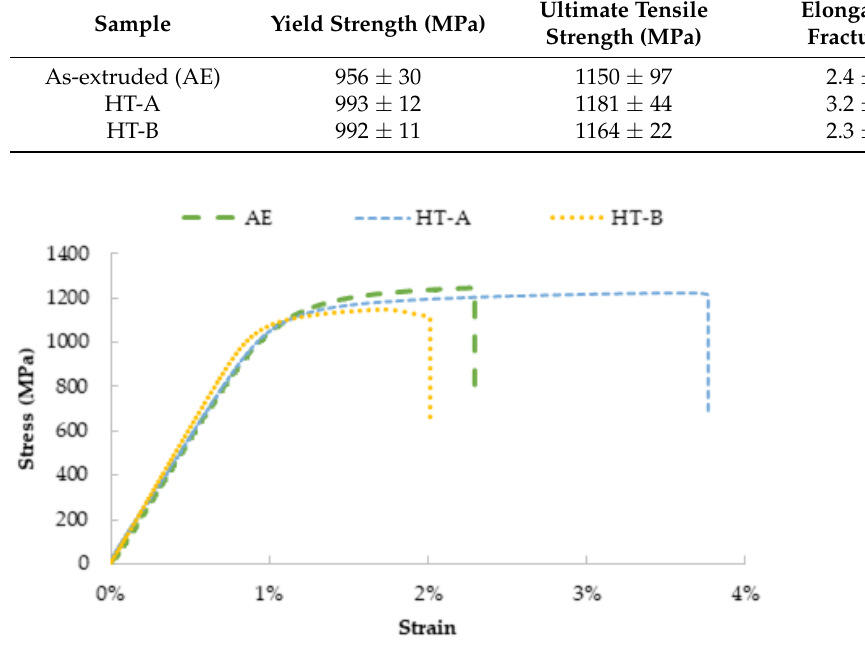
Figure 6. Typical stress and strain curves of as-extruded and heat-treated Ti-6Al-4V alloy produced using thermomechanical powder consolidation (TPC) route.